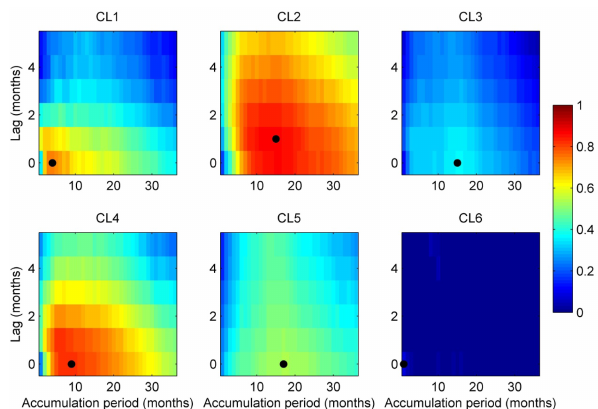
Figure 5. Heat maps of Pearson correlation between SGI and SPI for q = 1 to 36 months and for lags up to 5 months. Maximum cor- relation is denoted by the closed black